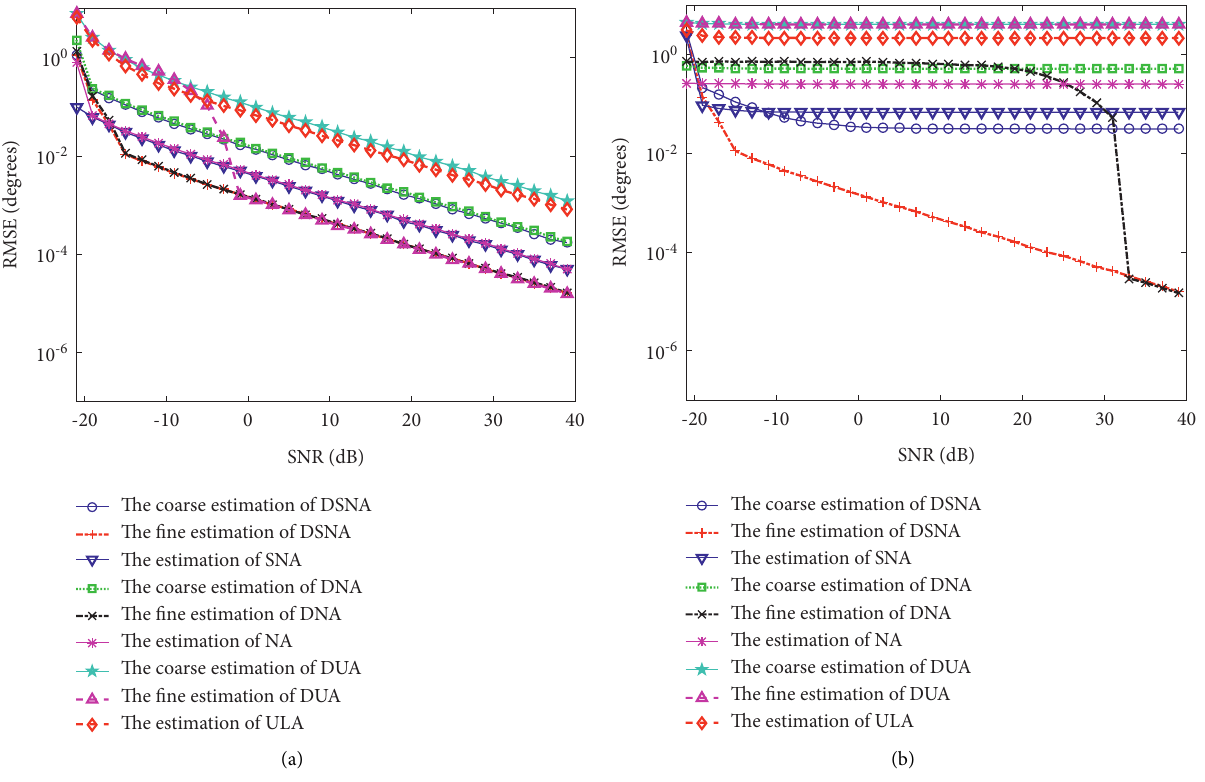
Figure 6: Single-source signal and d � λ /6; the baseline length is 63 times the wavelength. (a) Not considering mutual coupling between the array antennas. (b) Considering mutual coupling between the array antennas.